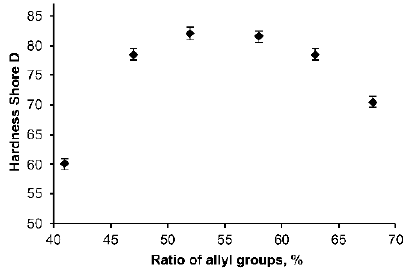
Figure 3 . Dependence of the hardness Shore D on the ratio of allyl groups in the OSTE-MS polymers.